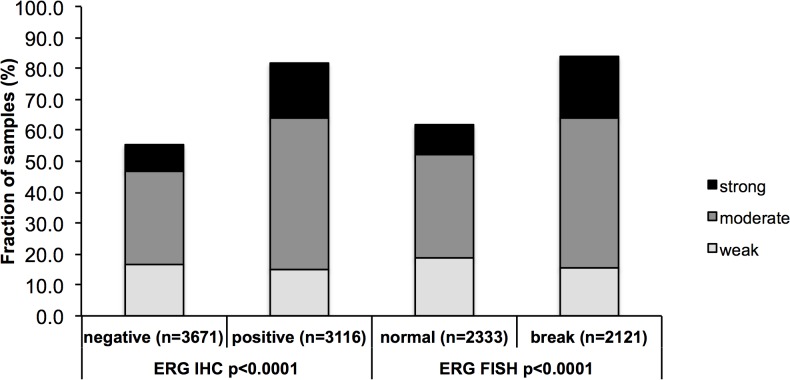
Relationship of SOX9 expression with ERG status.IHC = immunohistochemistry; FISH = fluorescence in-situ hybridization.